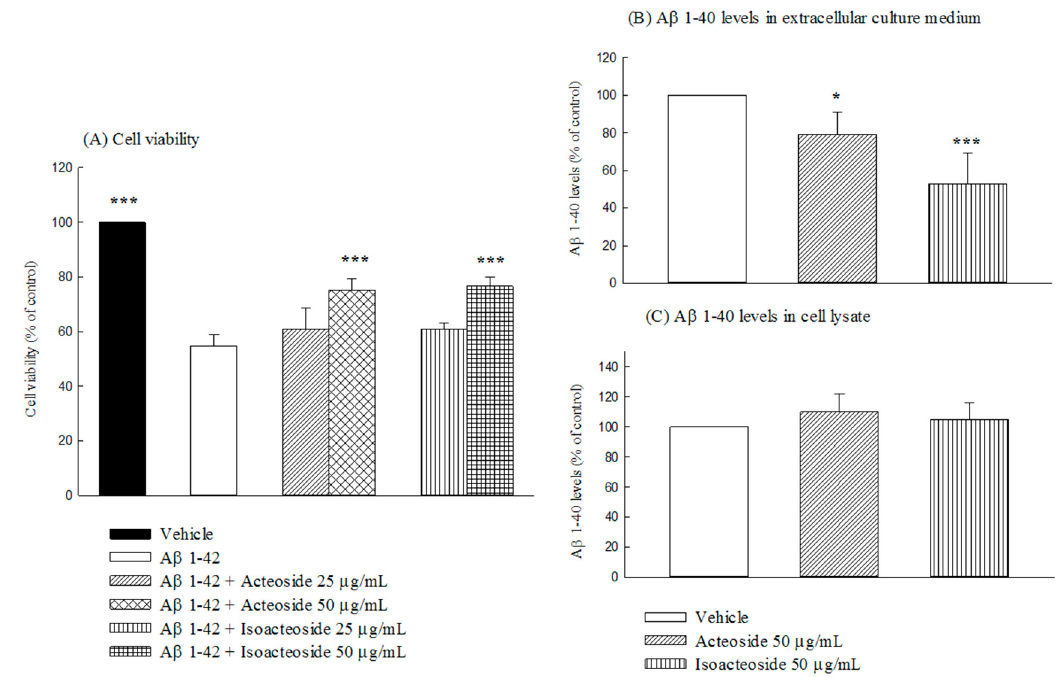
Figure 7. Effects of acteoside or isoacteoside (25, 50 μ g/mL) on A β 1-42 toxicity, and extracellular and intracellular A β 1-40 levels in SH-SY5Y cells: ( A ) cell viability; ( B ) A β 1-40 levels in extracellular culture medium; and ( C ) A β 1-40 levels in cell lysate. Acteoside or isoacteoside was administered 1 h before treatment with A β 1-42. Columns indicate mean ± SD ( n = 4). * p < 0.05, *** p < 0.001 compared with ( A ) A β 1-42-treated group or ( B , C ) vehicle group.